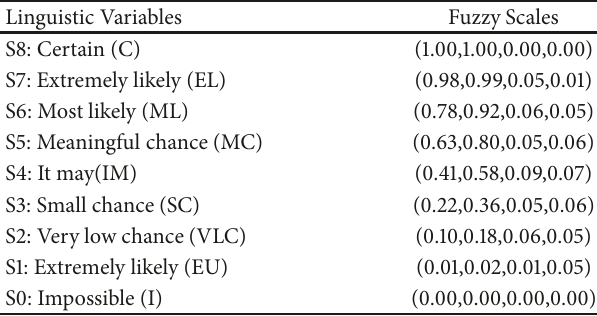
Table 3: Evaluation of verbal and linguistic terms [20].